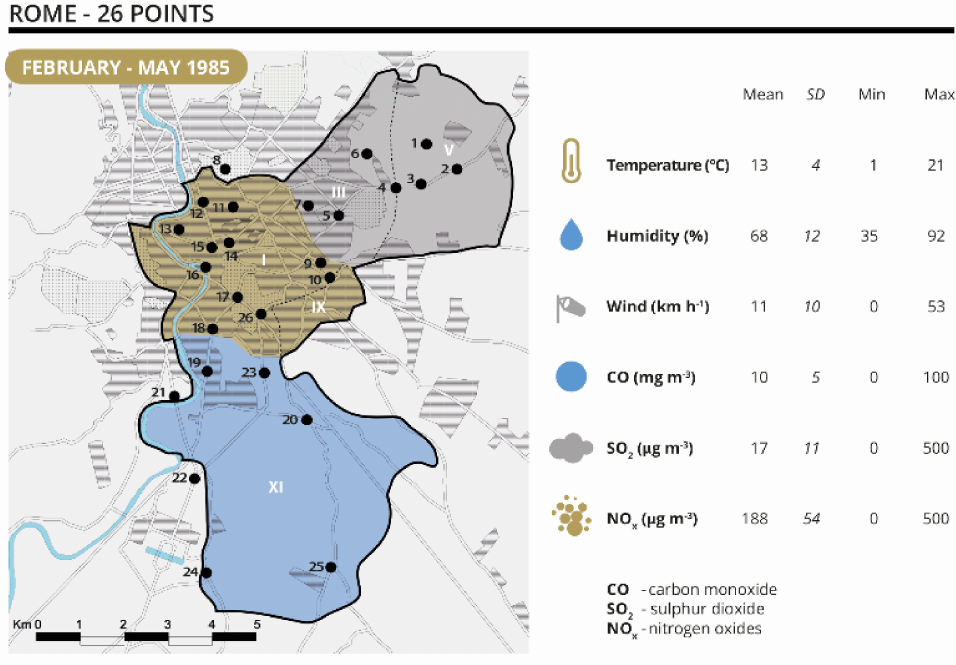
Figure 3. Air pollution monitoring: the map on the left shows the sampling points and the three areas of the City of Rome, which will be referred to later in order to report the averaged data. On the right, the descriptive statistics, referring to the entire city, of the main meteorological parameters and of the average of gases analyzed. Samples of three gases were collected three days per week (Monday, Friday and Sunday) at 7:30 am, 2:30 pm and 6:30 pm. At the same time, the students were locating and checking the health conditions of approximately 3000 pines, located in the proximity of gas sampling points.